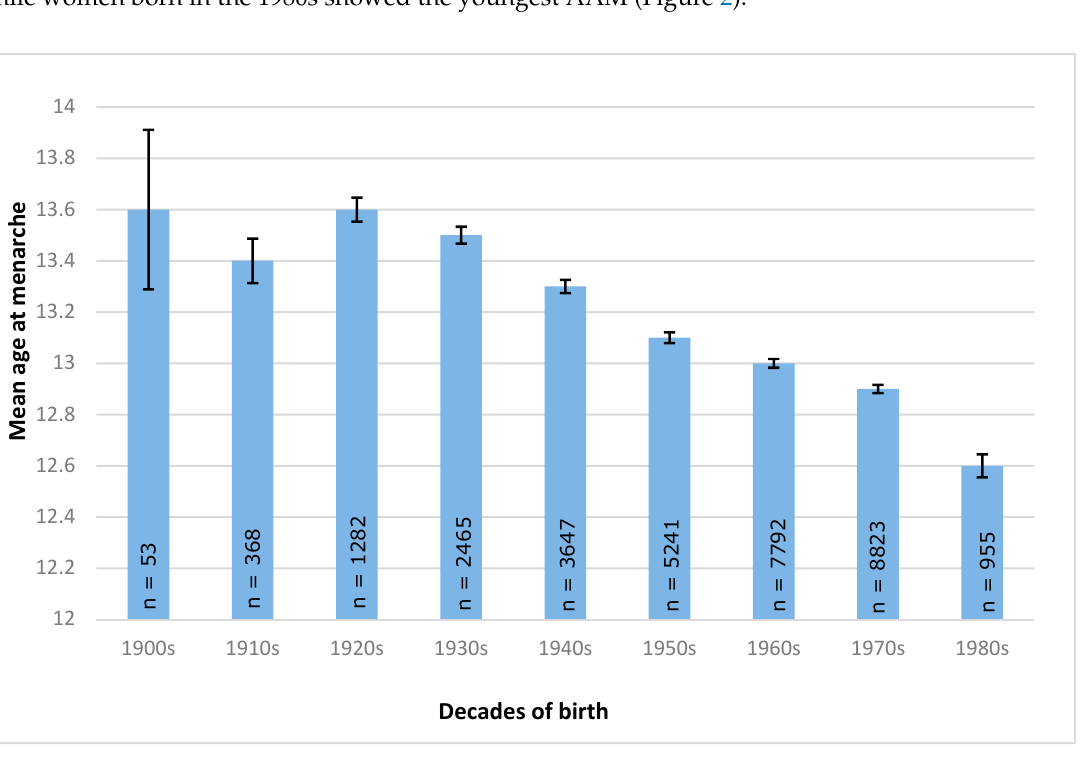
Table 2. Association between age at menarche and nutritional status.